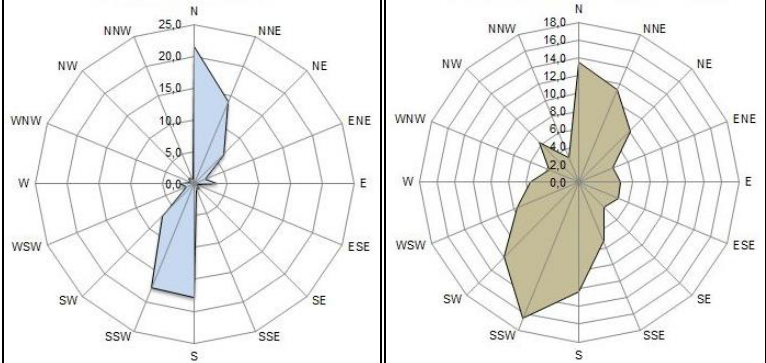
Figure 1. Wind rose for